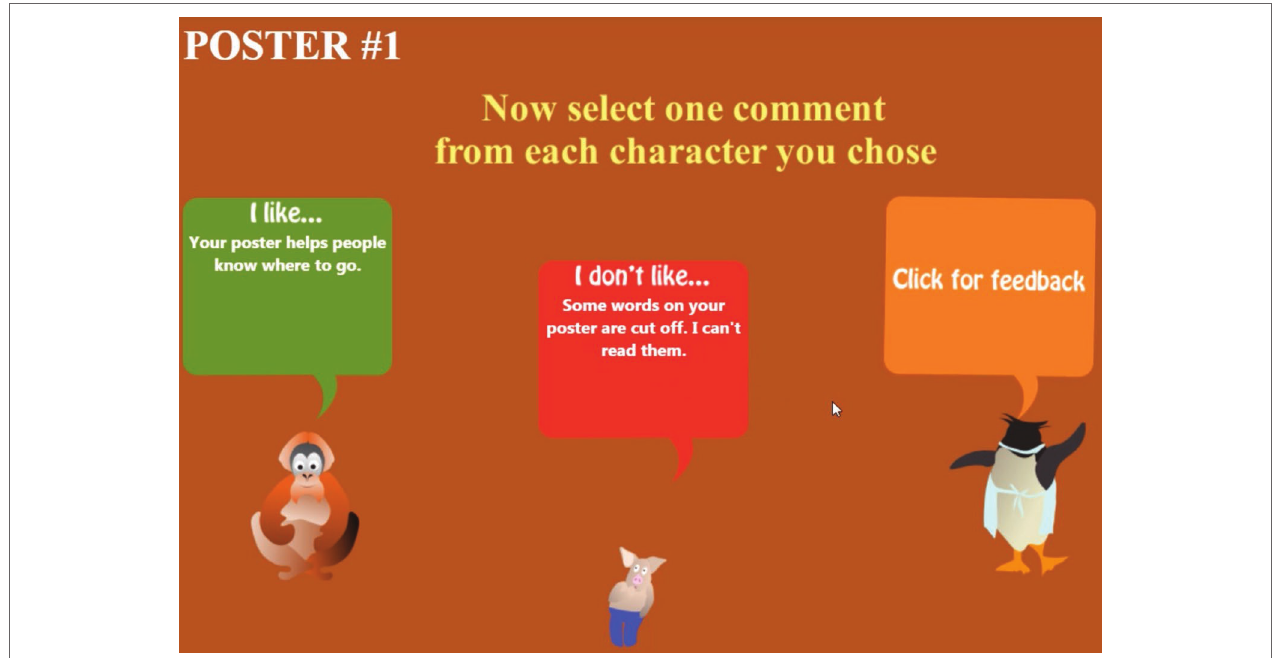
FIGURE 3 | In the Assign condition, players click on the orange box (“Click for feedback”) to reveal the feedback assigned to them, through a yoked experimental design, of the same valence and order of a matched participant in the choose condition.